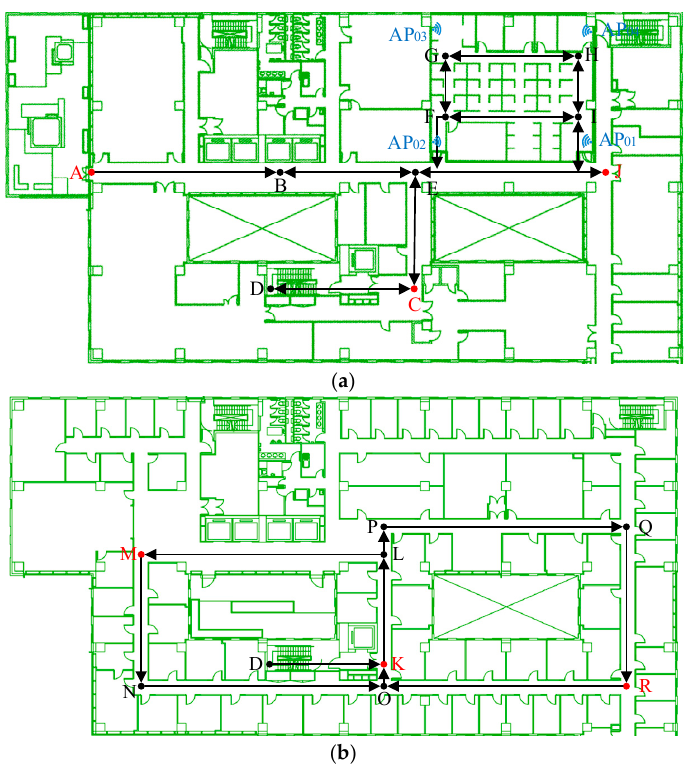
Figure 4. ( a )The 10th Floor of an Office Building; ( b ) The 9th Floor of an Office Building.